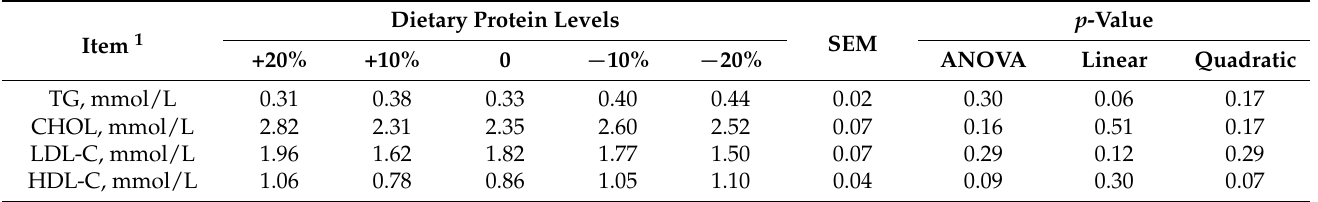
Table 2. Blood chemical parameters of lipid metabolism of pigs fed different protein